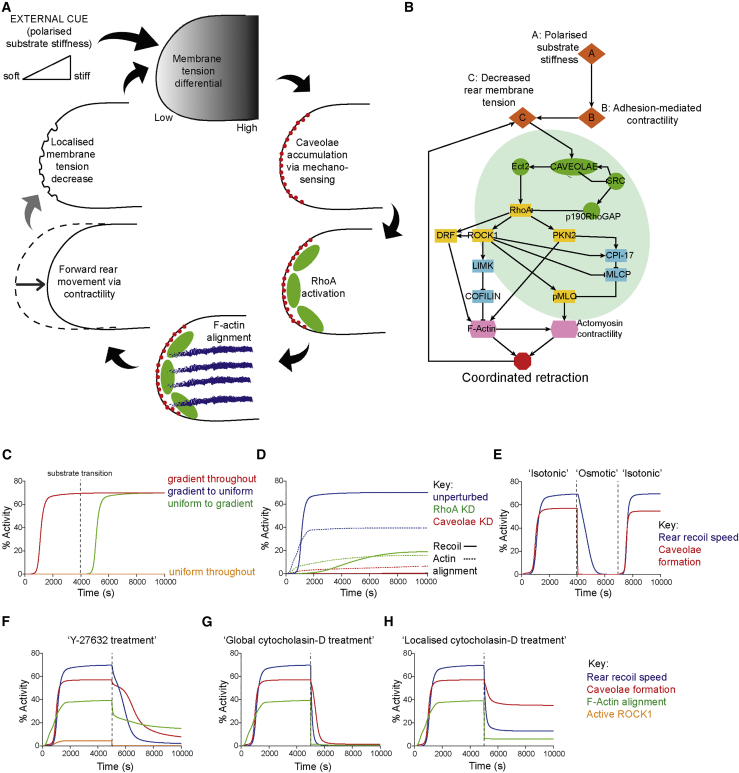
Mathematical Modeling Implicates a Positive-Feedback-Based Mechanism of Rear Retraction(A) Schematic summary of key rear retraction events for migrating cells in 3D or durotaxis.(B) Wiring diagram of mechanochemical signaling interactions that lead to coordinated retraction, upon which the ordinary differential equations (ODE) model and simulations are based.(C) Simulations output of rear recoil speed (% activity) against time with polarized substrate stiffness remaining at 100% (red) or at 0% throughout the time course (yellow), or transitioning from 100% to 0% (gradient to uniform, blue, hidden by red line) or 0% to 100% (uniform to gradient, green) at time t = 4,000 s.(D) Simulation outputs for rear recoil speed and F-actin alignment for unperturbed, RhoA, and caveolae knockdown initial conditions.(E) Simulation of reversible osmotic shock, where membrane tension is increased at t = 4,000 s and returned to basal level at t = 7,000 s; rear recoil speed and caveolae formation shown.(F) Predictive simulation of Y-27632 treatment effect on caveolae dynamics and rear recoil speed, where at t = 5,000 s ROCK1/PKN-2 inactivation rates are greatly increased.(G) Predictive simulation of “global” cytochalasin-D treatment on caveolae dynamics/rear recoil speed, where at t = 5,000 s, F-actin turnover rate is greatly increased.(H) As in G but for “local” cytochalasin-D, where at t = 5,000 s, F-actin turnover rate is moderately increased.See also Figure S6.